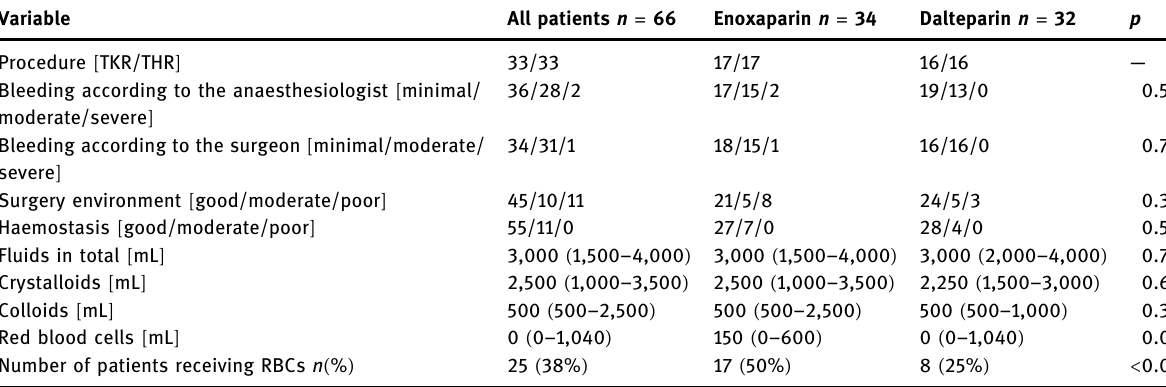
Table 2: Surgery - related characteristics: procedure type, blood loss and transfused fl uids